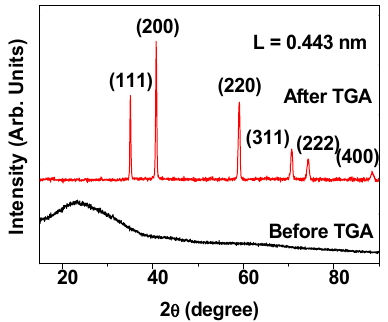
Figure 4. XRD patterns before and after thermogravimetric analysis (TGA). The post-TGA peaks were assigned with (hkl) Miller indices. “L”: cell constant of MnO.